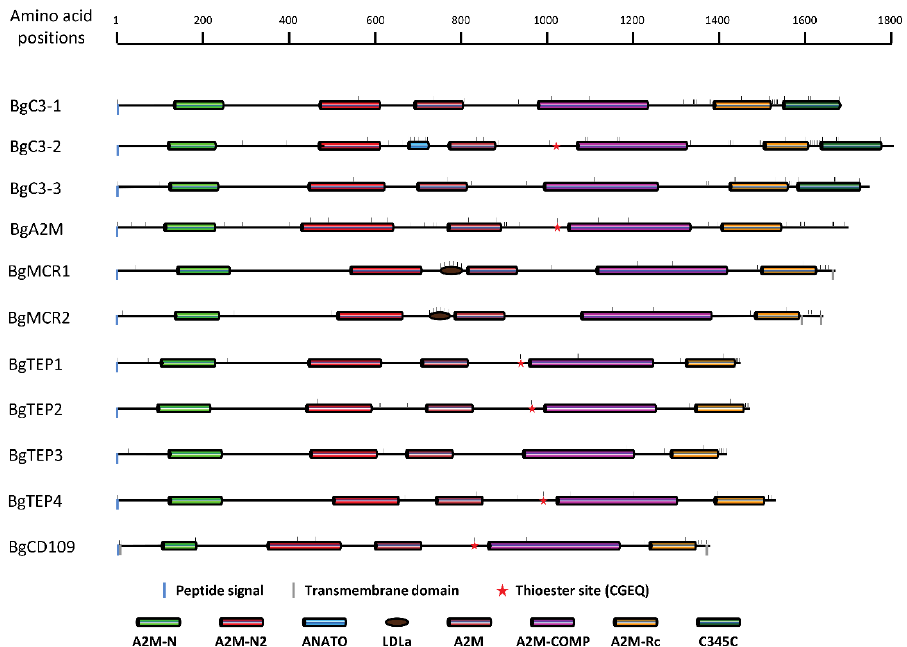
Figure 2. Schematic representation of BgTEP protein domains organization. Colored rectangles correspond to SMART conserved domains with following accession number: N-terminal alpha2-macroglobulin domain (A2M-N, PF01835), N-terminal α -2-macroglobulin domain2